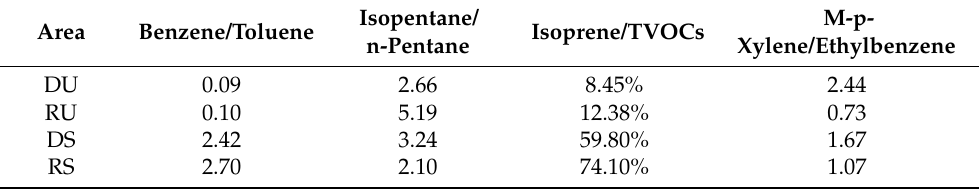
Table 4. Species ratio in dry and rainy seasons in urban and suburban areas of Jinghong. Area Benzene/Toluene